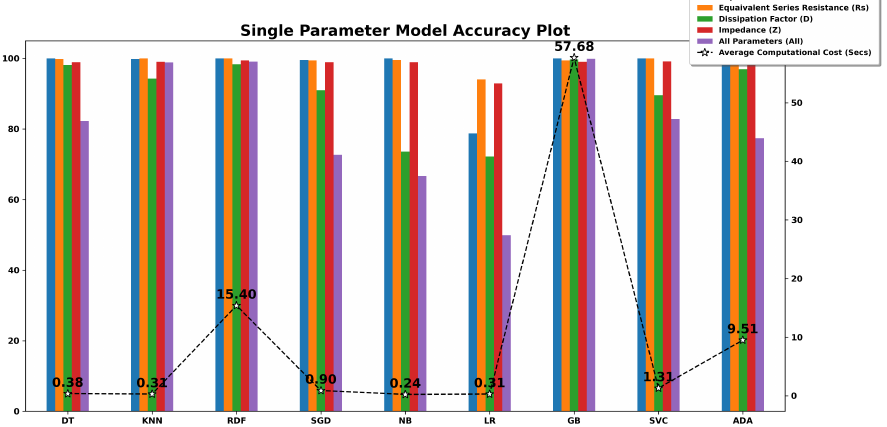
Figure 23. Bar plot showing the model accuracy and average computational costs across the algo- rithms (secs).